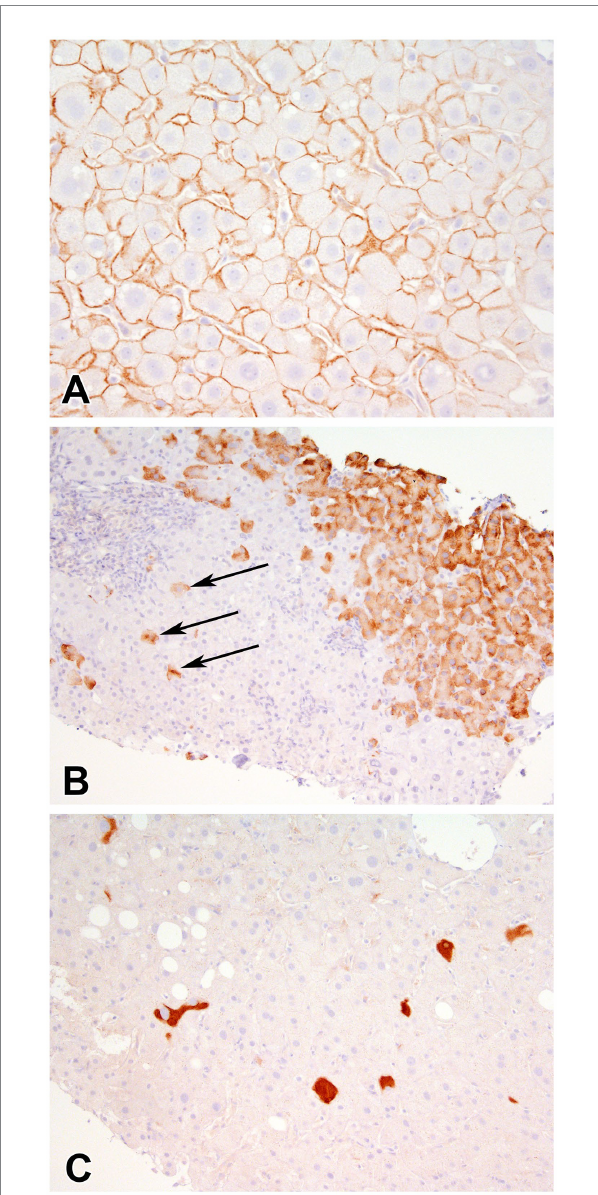
FIGURE 2 Immunohistochemical stain for Hepatitis B Surface antigen showing (A) membranous staining (400x), (B) scattered granular (arrows) and contiguous granular cytoplasmic staining (400X), and (C) inclusion- like (200X) staining of